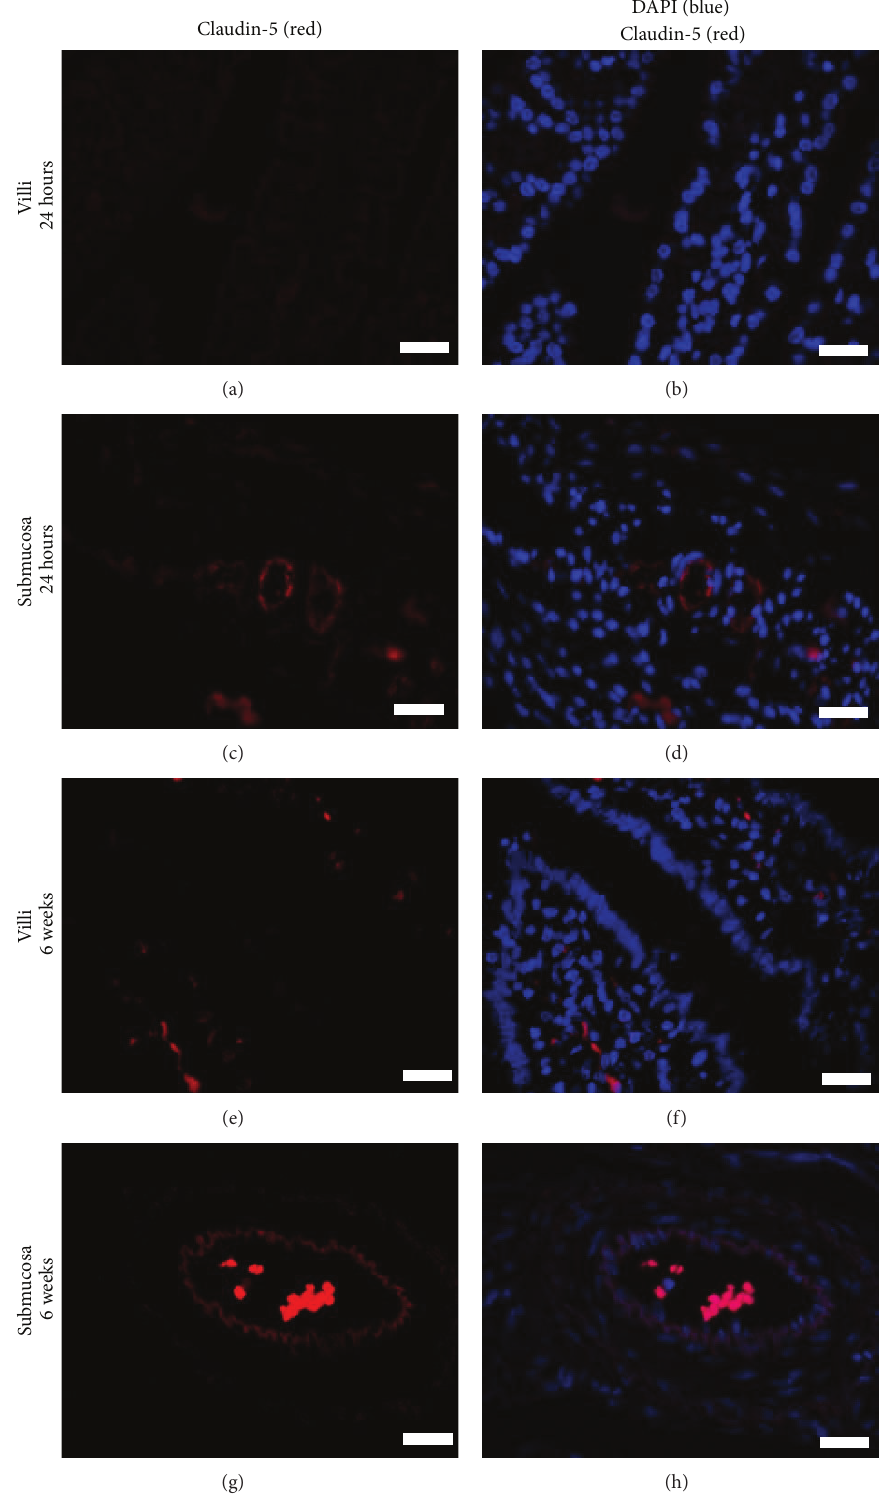
Figure 4: Claudin-5 surface localization on blood vessel endothelial cells does not change over time. Claudin-5 is absent from the surface of jejunal enterocytes in 24-hour-old ((a), (b)) and 6-week-old piglets ((e), (f)), respectively but it is present on the blood vessel walls in the submucosa for both age groups ((c), (d), (g), and (h)). Red cells within villi are from autofluorescent cells and red cells within the blood vessels are red blood cells. These images are representatives of IHC performed on tissue from 3 animals per time point. Primary antibody: rabbit anti-Claudin-5. Secondary antibody: PE-labeled goat anti-rabbit (red). Nuclear stain: DAPI (blue). Scale bar represents 40 𝜇